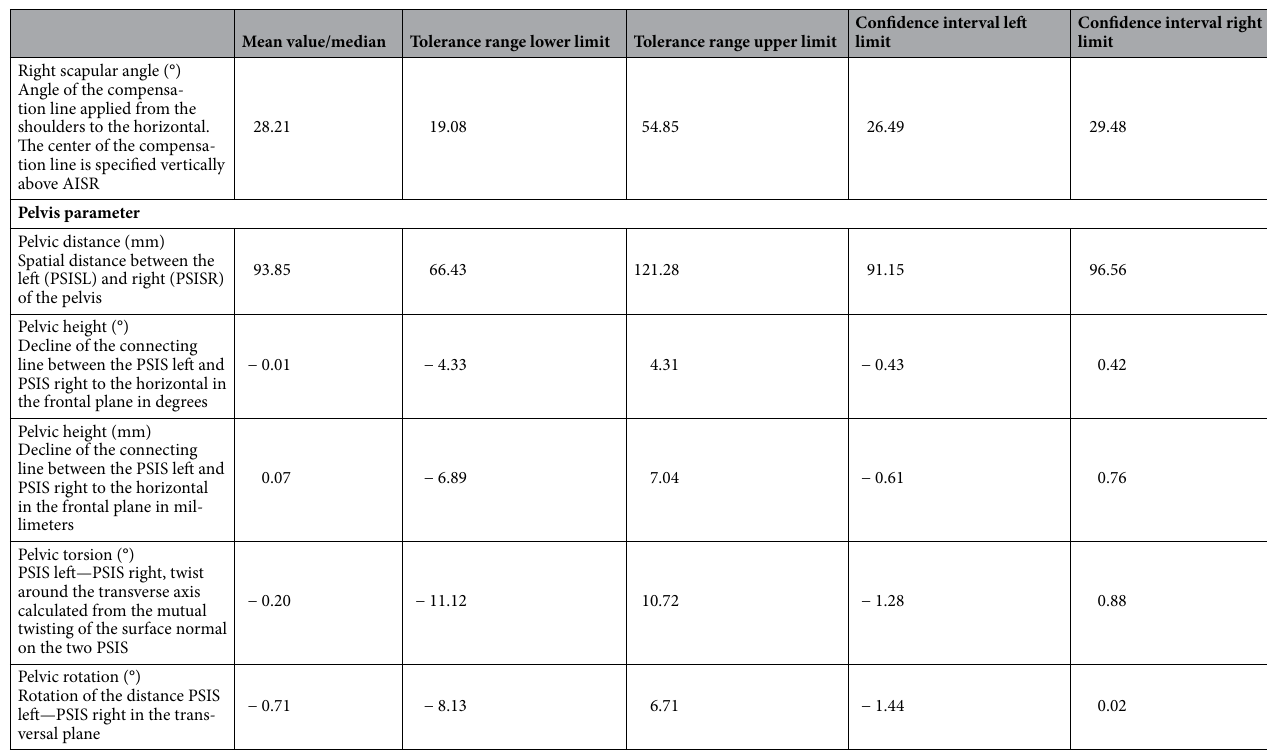
Table 1. Representation of the median/mean values, the tolerance ranges with lower and upper limits and the confidence intervals with left and right limits for all back